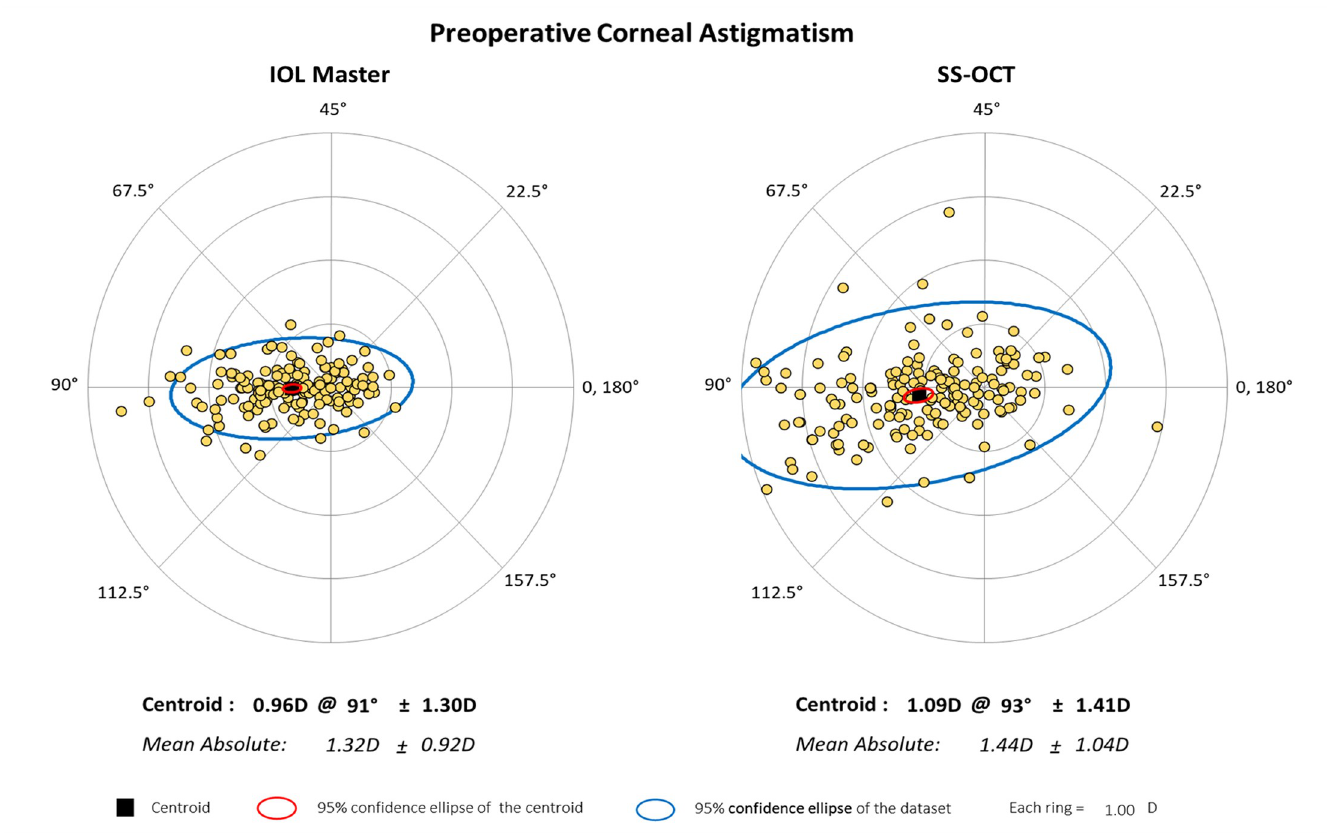
Fig 3. Preoperative astigmatism using double-angle plot of two biometry.